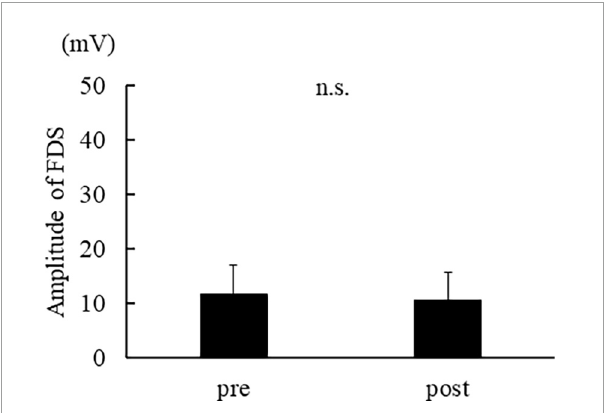
FIGURE4 The average of FDS muscle activation. The error bar indicates the standard deviation.